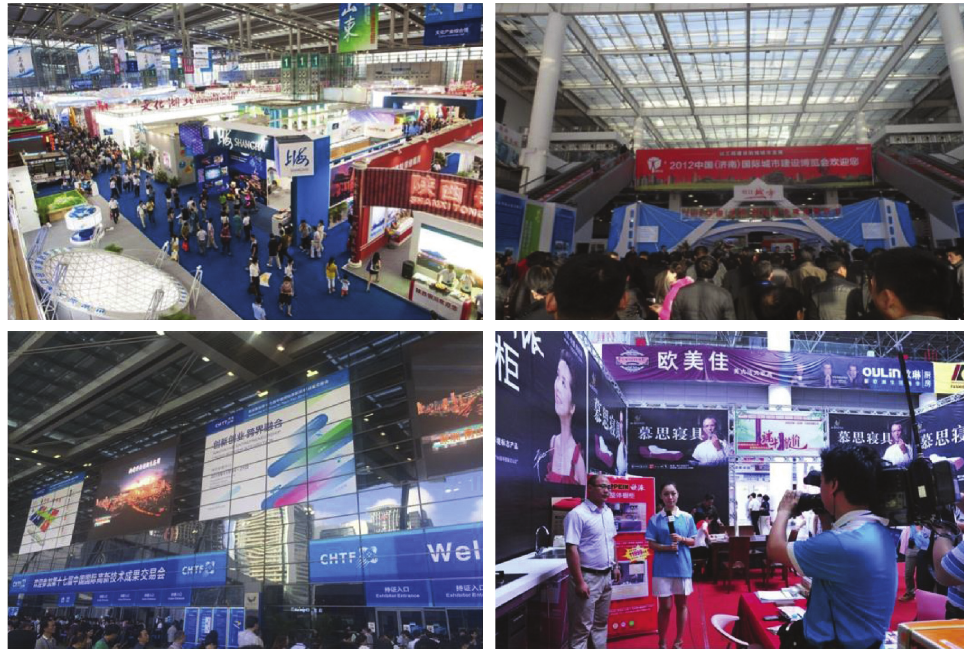
Figure 1: Various forms of exhibition